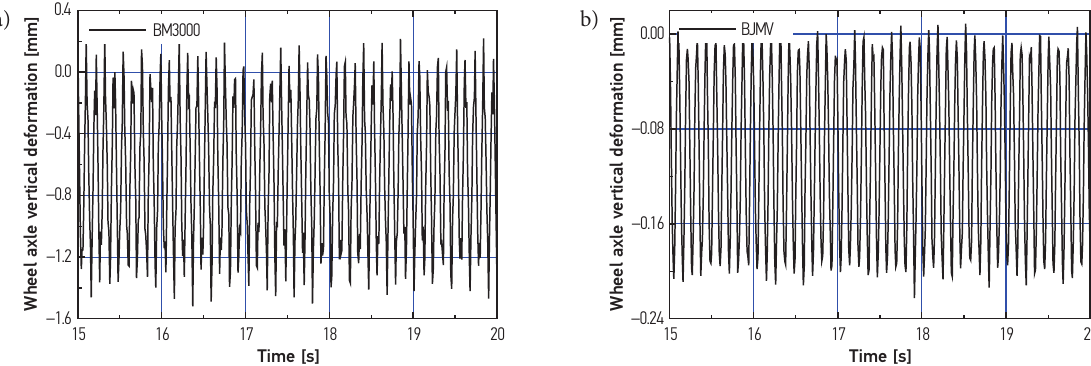
Fig. 10. Time history of wheel axle deformation changes of two kinds of wheelset models: a – BM3000; b – BJMV